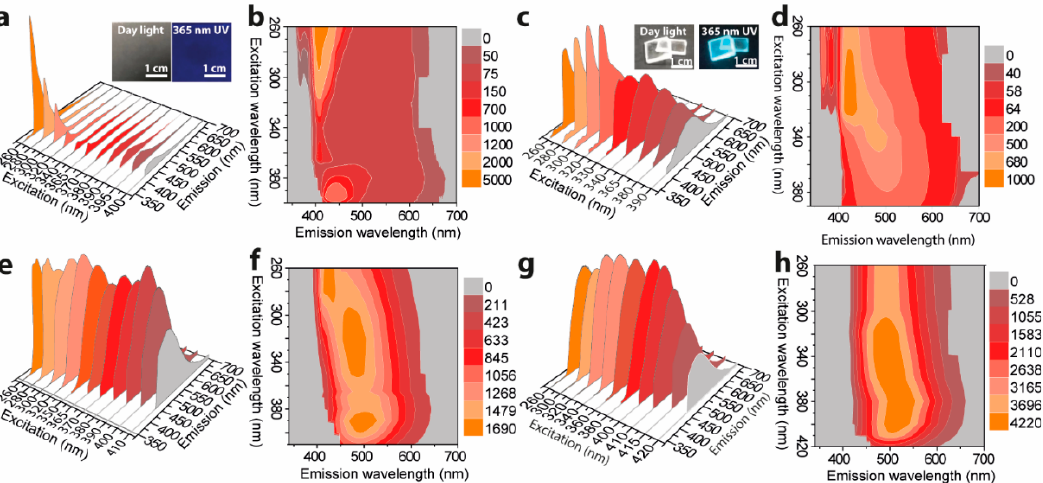
Figure 6. Excitation wavelength dependent 3D and 2D emission spectra of S-TPE-1 (10 mg/mL) processed with the 70 °C of heat treatment for ( a , b ) 0, ( c , d ) 30, ( e , f ) 60, and ( g , h ) 120 min.